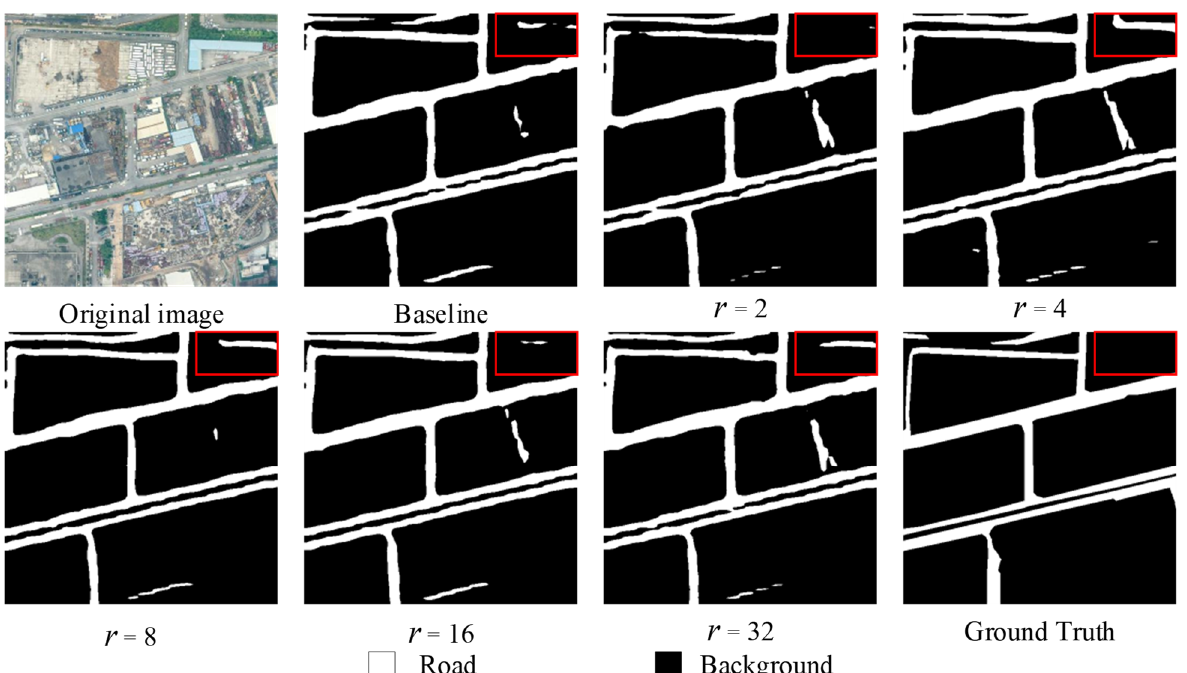
Figure 11. Comparison of visual results of dimensionality reduction based on the CHN6-CUG dataset.